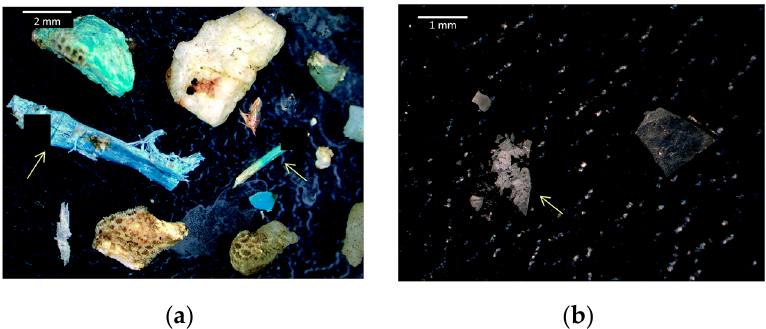
Figure 2. Images of Pacific Ocean trawl microplastic particles, a ) primary and b ) secondary microplastics, some with adhered crustaceans, mineral crusts, or radiolarians (taken from reference [19] with permission of the Royal Society of Chemistry).